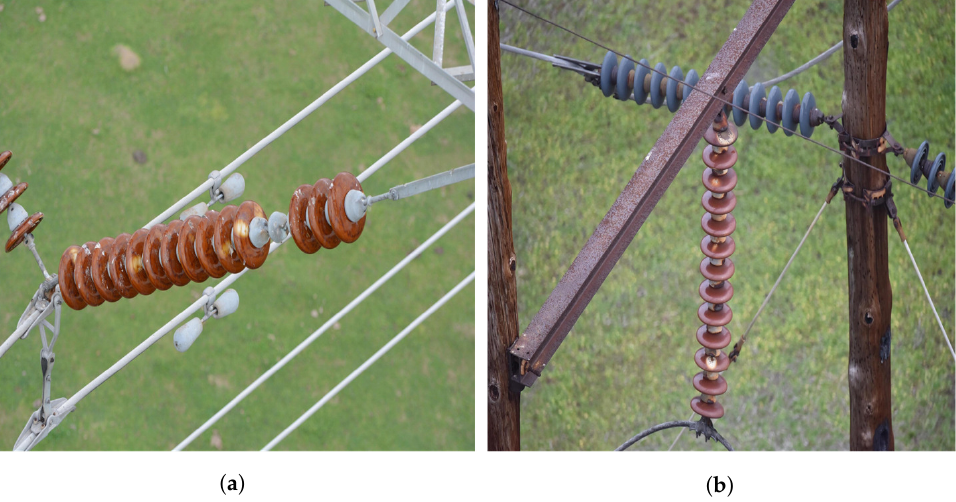
Figure 9. Samples with uneven complexity: ( a ) easily divided samples; ( b ) hard-to-classify